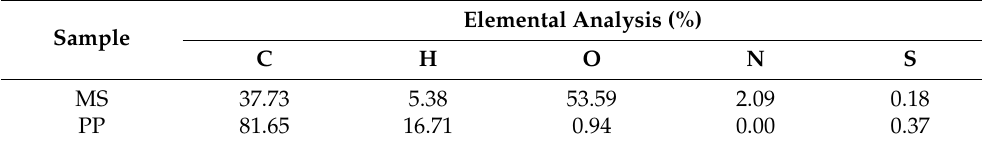
Table 1. Elemental analysis of MS and PP.